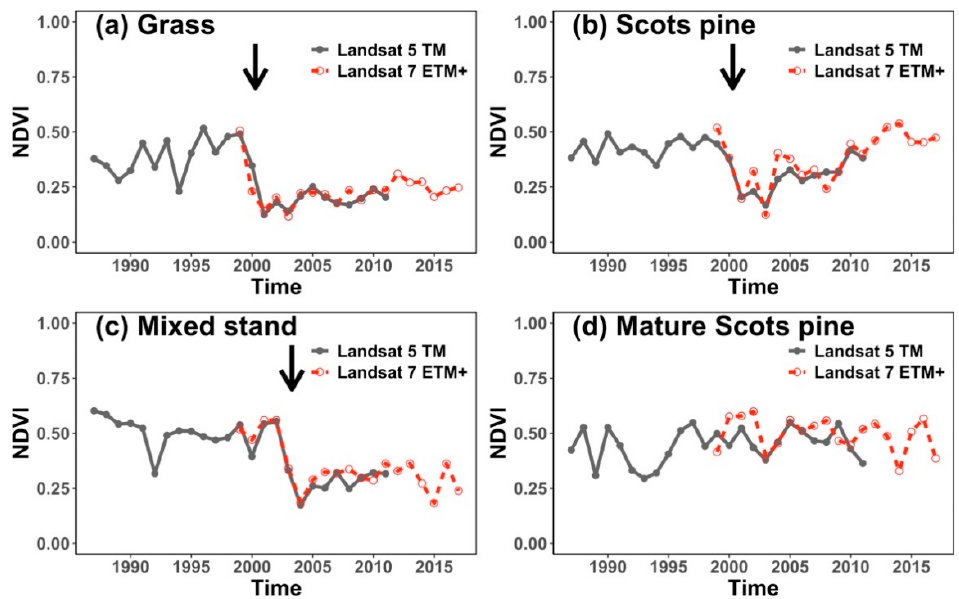
Figure 5. Examples of Landsat-derived NDVI time series of study sites that are undertaking different recovery trajectories post-fire: ( a ) grass-dominated site, ( b ) abundantly recruiting Scots pine site, ( c ) mixed stand and ( d ) mature Scots pine stand that has not been burnt since 1987. NDVI values are the maximum of each observational year. TM data recorded from 1987 to 2011 and ETM+ data recorded from 1999 to 2017 are presented. Arrow indicates occurrence of fire event.